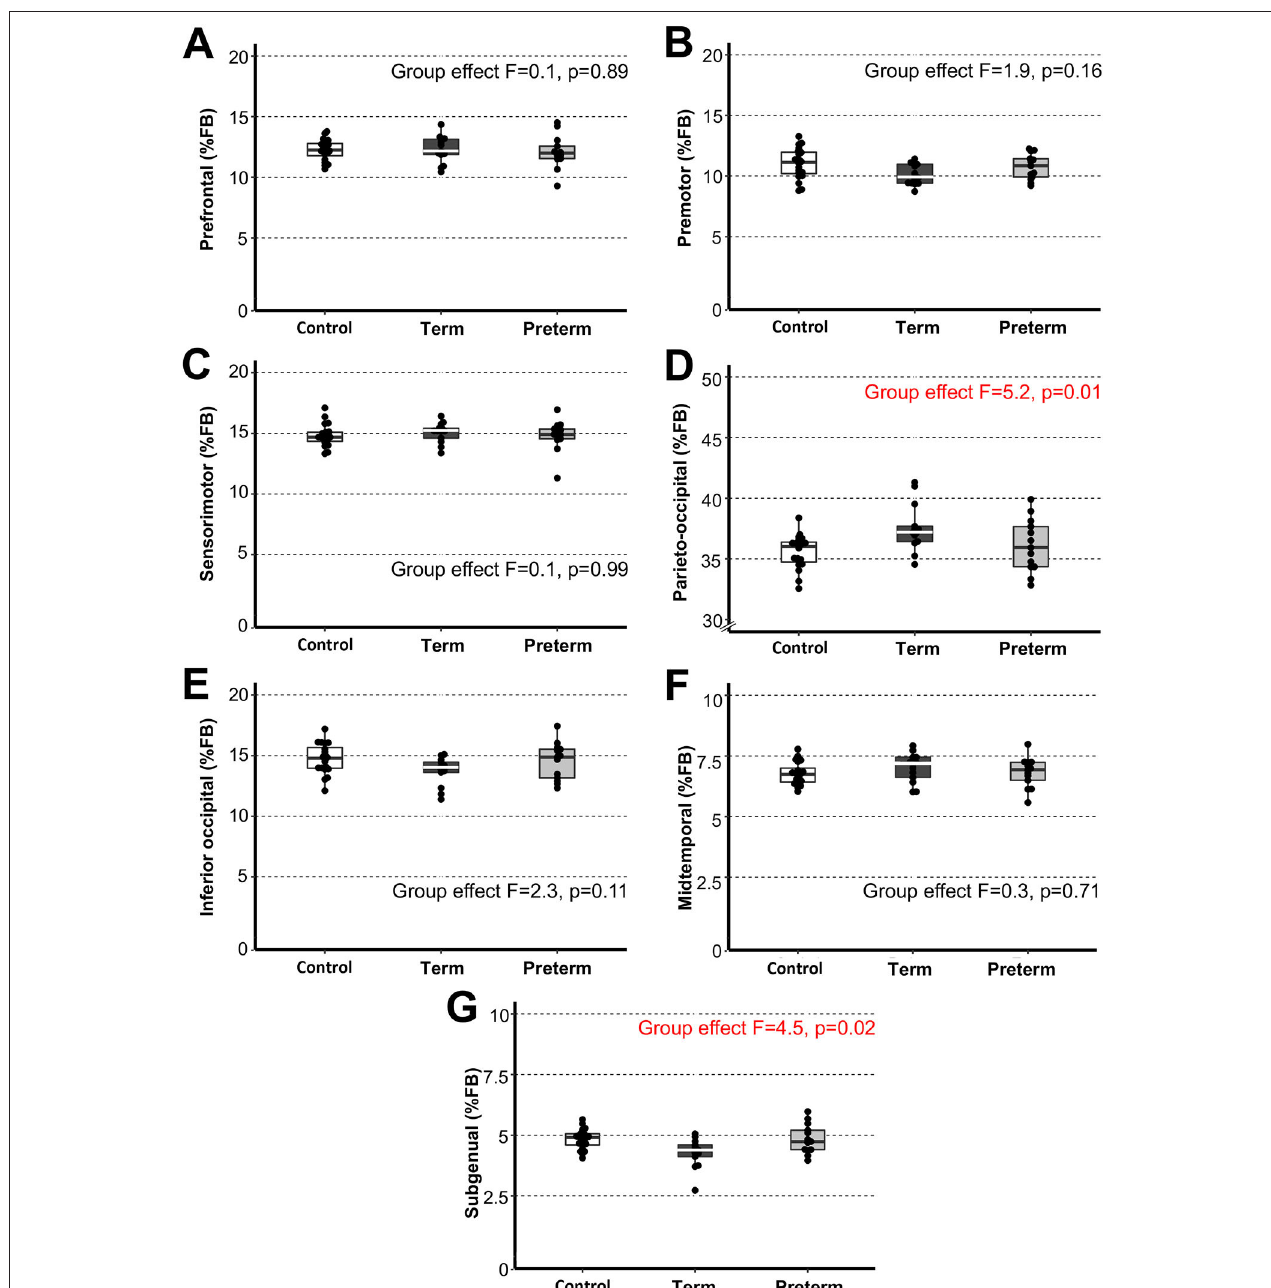
FIGURE 4 | Sub-regional forebrain volumes. Graphs display individual normalized sub-regional volumes (A–G) as a % forebrain (FB) volume for the three study groups: (1) term-born controls ( n = 20; white box), (2) term-born patients ( n = 13; black box), and (3) preterm-born patients ( n = 13; gray box). As noted in Methods section, forebrain volume was not available for 1/21 controls due to incomplete brain coverage, which accounts for final control group n = 20. We report no group differences for normalized sub-regional forebrain volumes with exception for normalized parieto-occipital (D) and subgenual (G) sub-regions between term-born patients and controls ( p ≤ 0.01) and between patient groups ( p ≤ 0.04), but not preterm patients and controls ( p ≥ 0.42). See also Table 3 for complete statistics. The latter findings may be attributed to higher variability of data in premature patients and should be interpreted with caution. Dots represent individual data values, boxes represent the interquartile range (25–75%), and solid horizontal lines represent medians.